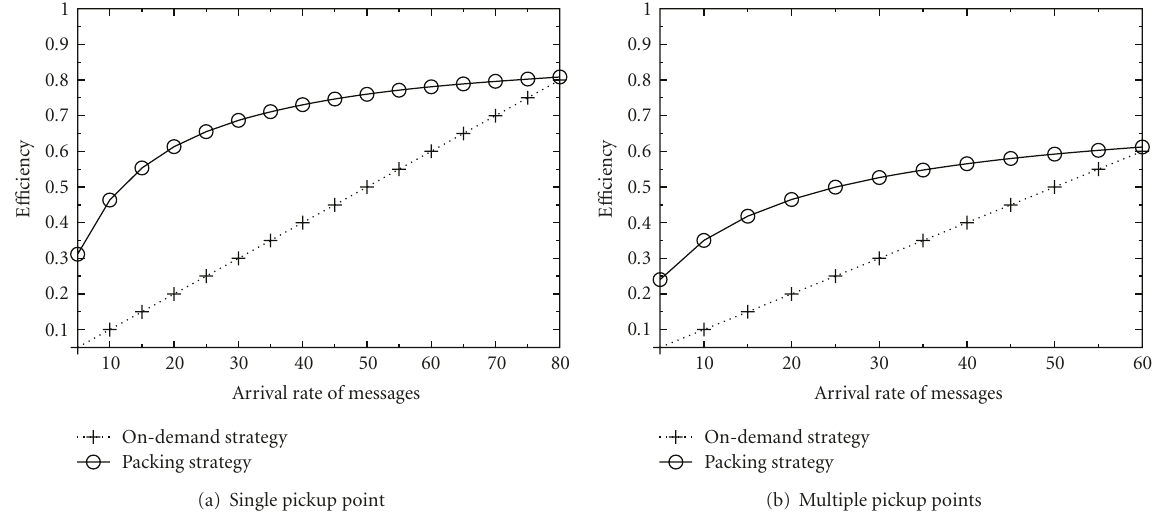
Figure 6: Comparison of e ffi ciency for the two